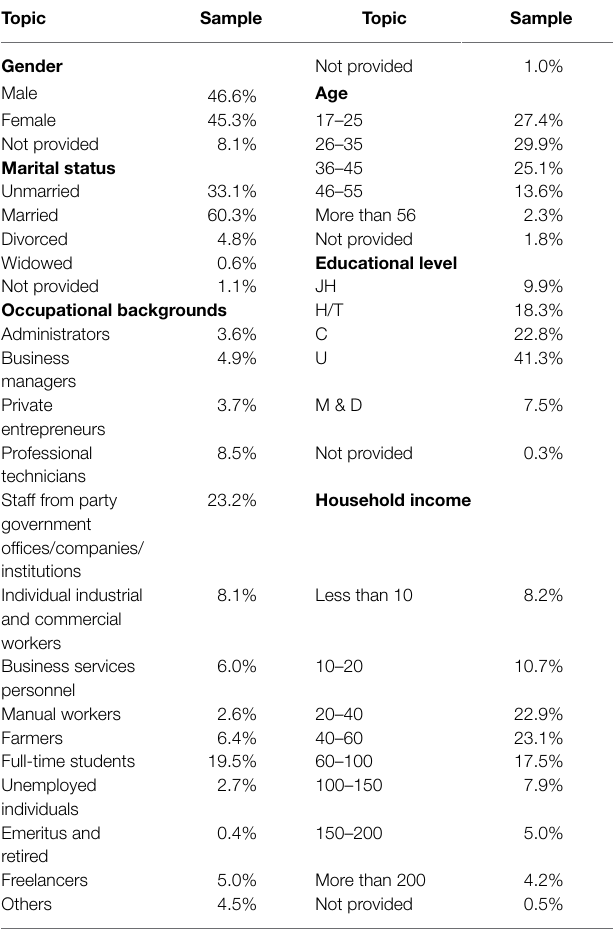
TABLE 1 | The sociodemographic characteristics of